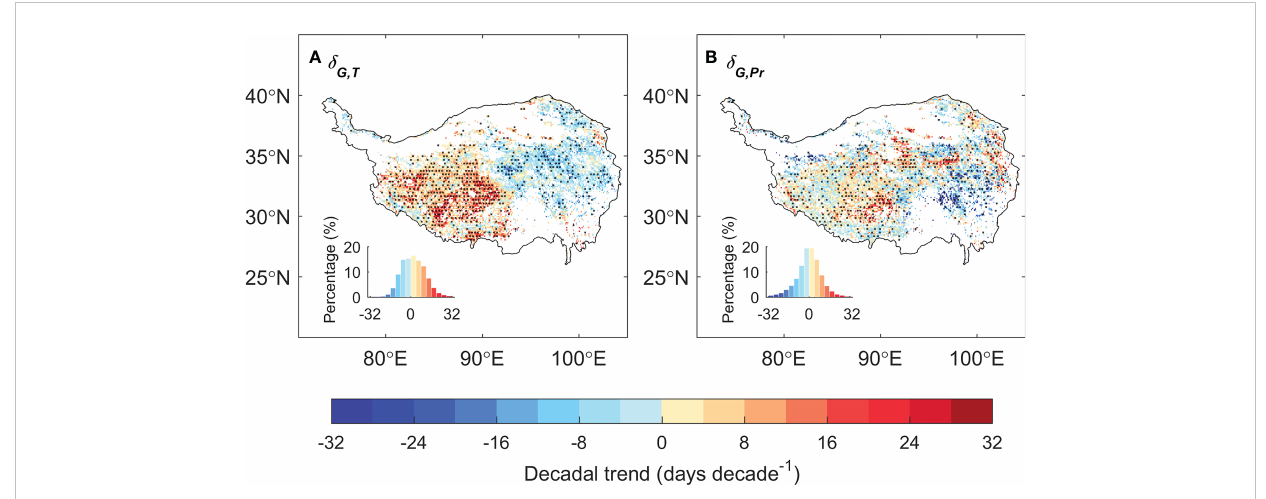
FIGURE 4 The spatial pattern of the decadal trend for the difference of the date of peak vegetation growth against the date of peak temperature ( d G,T , A ) and peak precipitation ( d G,Pr , B